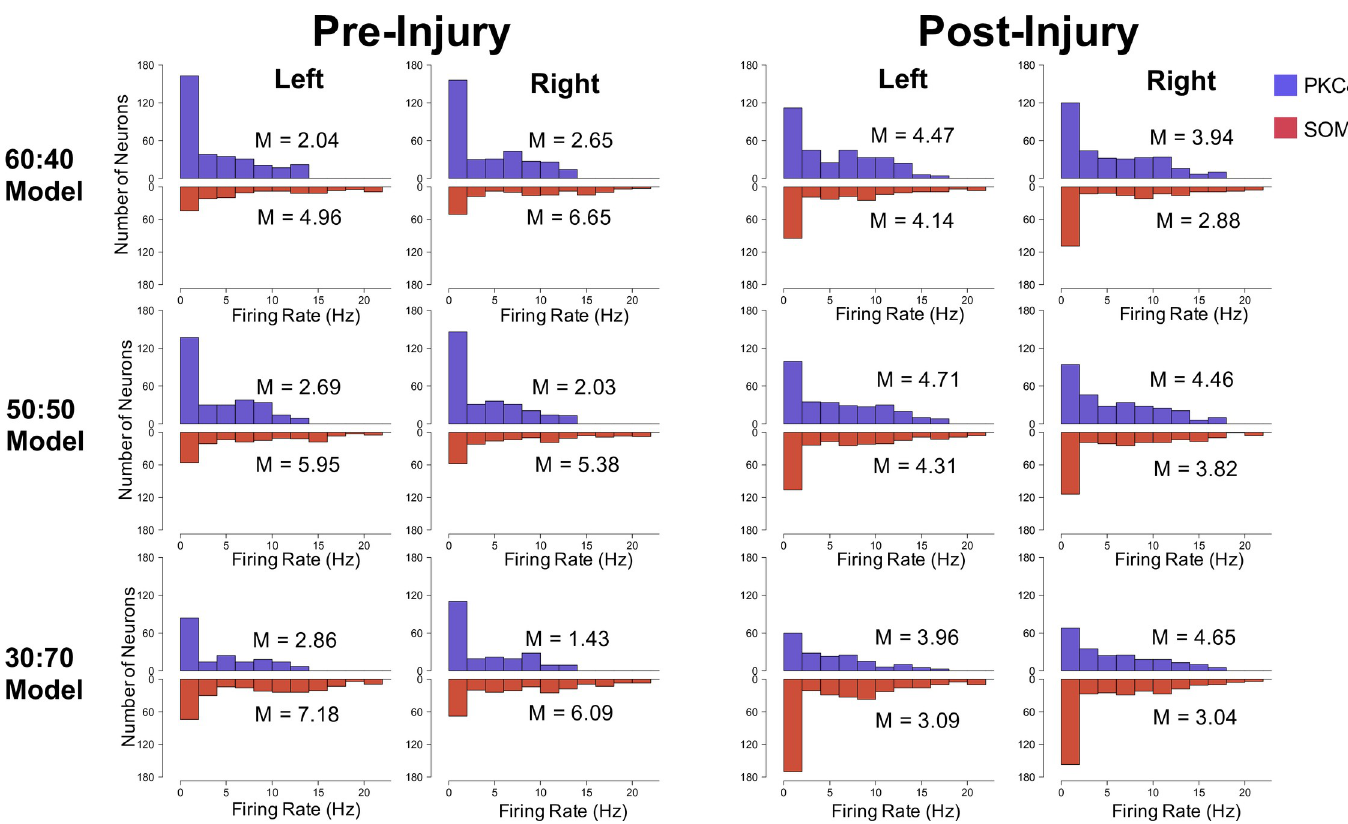
Fig 8. Aggregated PKC δ and SOM firing rates before and after injury. Histograms show the distributions of firing rates for all PKC δ RS and LF neurons (blue) and all SOM RS and LF neurons (red) before injury ( t = 10) and after injury ( t = 240) during constant 120 pA stimulation. The median firing rate (M) is provided for each distribution. In all three models (50:50, 60:40, 30:70), the post-injury firing rates of PKC δ neurons are significantly higher than their corresponding pre-injury firing rates (P < 0.05) and the post-injury firing rates of SOM neurons are significantly less than their corresponding pre-injury firing rates (P < 0.05) with the exception of left side SOM neurons in the 50:50 model (P = 0.053). There are no statistically significant differences in the corresponding distributions of firing rates between hemispheres (Left vs. Right) or across models (e.g., 50:50 vs.